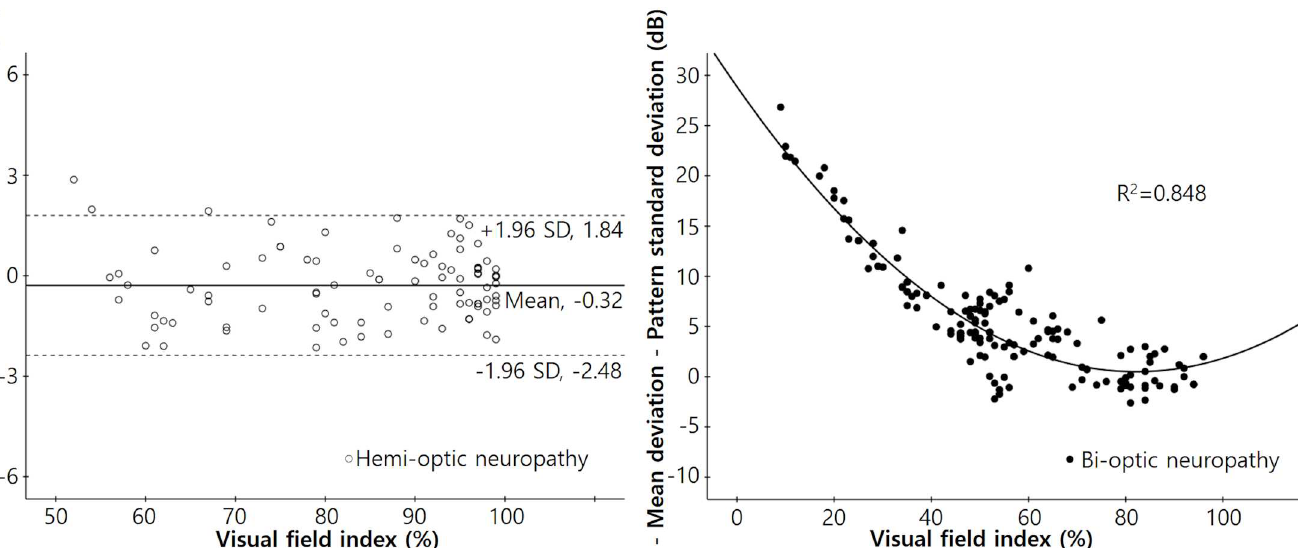
PLOS ONE | DOI:10.1371/journal.pone.0171960 March 1,